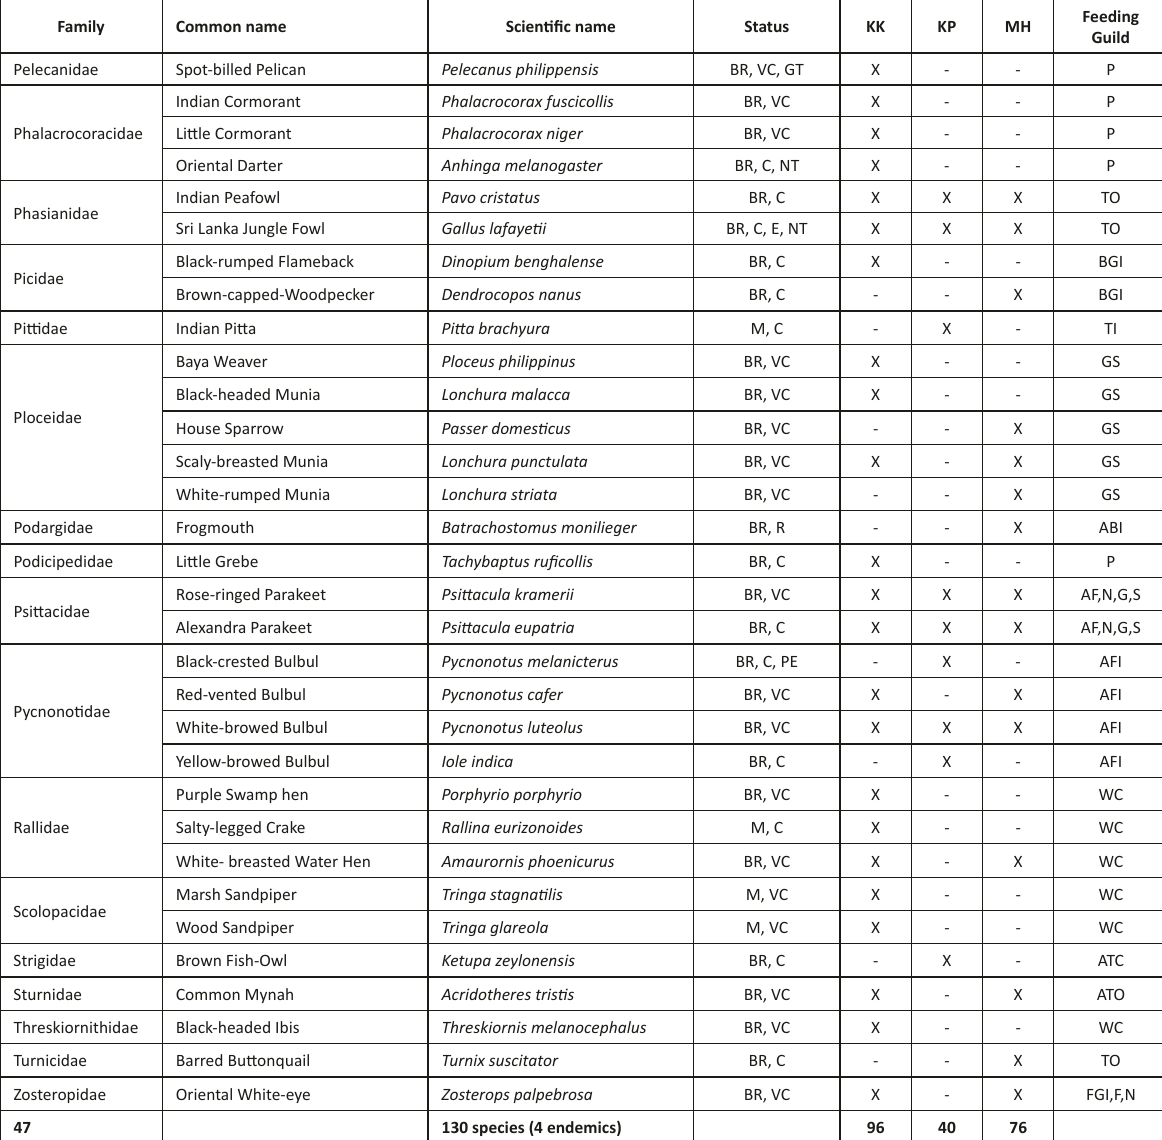
Feeding Guild: ABI - Arboreal Insectivore; AI - Areal Insectivore; FGI - Foliage Gleaning Insectivore; BGI - Bark-Gleaning Insectivore; TI - Terrestrial Insectivore; GI - grassland Insectivore; AC - Aerial Carnivore; ATC - Arboreal-Terrestrial Carnivore; WC - Wading Carnivore; AN - Arboreal Nectarivore; AF - Arboreal Frugivore; AFNGS - Arboreal Frugivore, Nectarivore, Granivore, Seed-eater; GS - Granivore, Seed-eater; AFI - Arboreal Frugivore, Insectivore; FGIFN - Foliage Gleaning Insctivore, Frugivore, Nectarivore; ATO - Arboreal-Terrestrial Omnivore; TO - Terrestrial Omnivore; P - Psicivore. Status: BR - Breeding Resident; M - Migrant; VC - Very Common; C - Common; R - Rare; VR - Very Rare; E - Endemic; PE - Proposed Endemic; GT - Globally Threatened; NT- Nationally